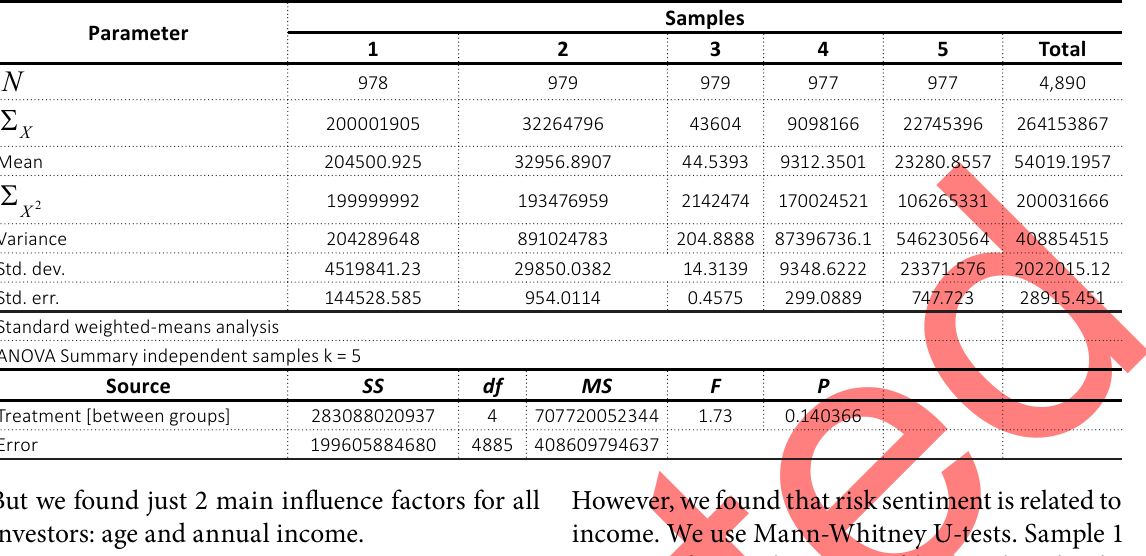
Table 3. ANOVA data summary